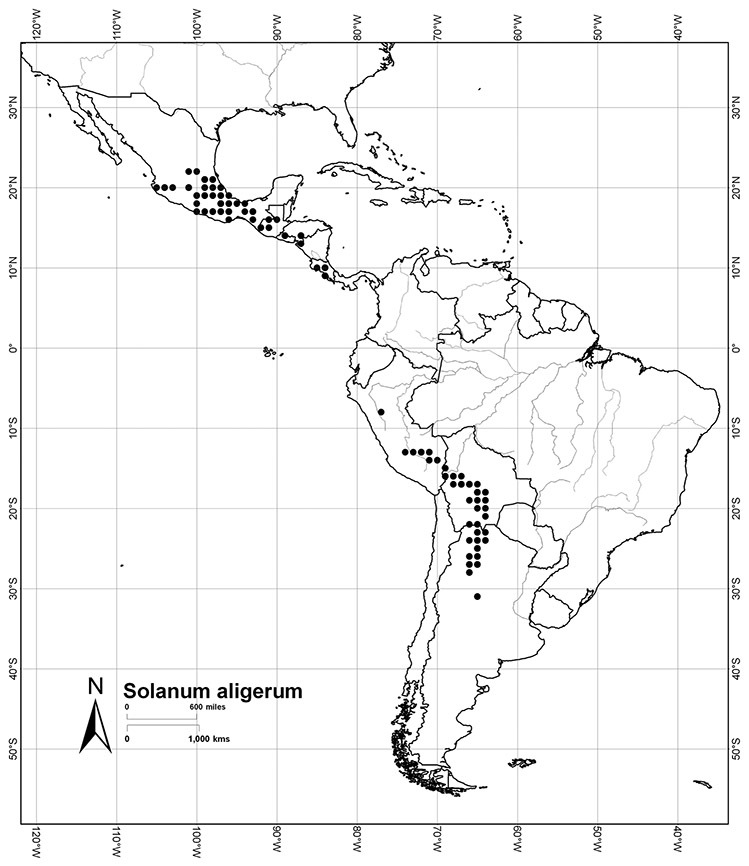
Distribution of Solanum aligerum Schltdl.